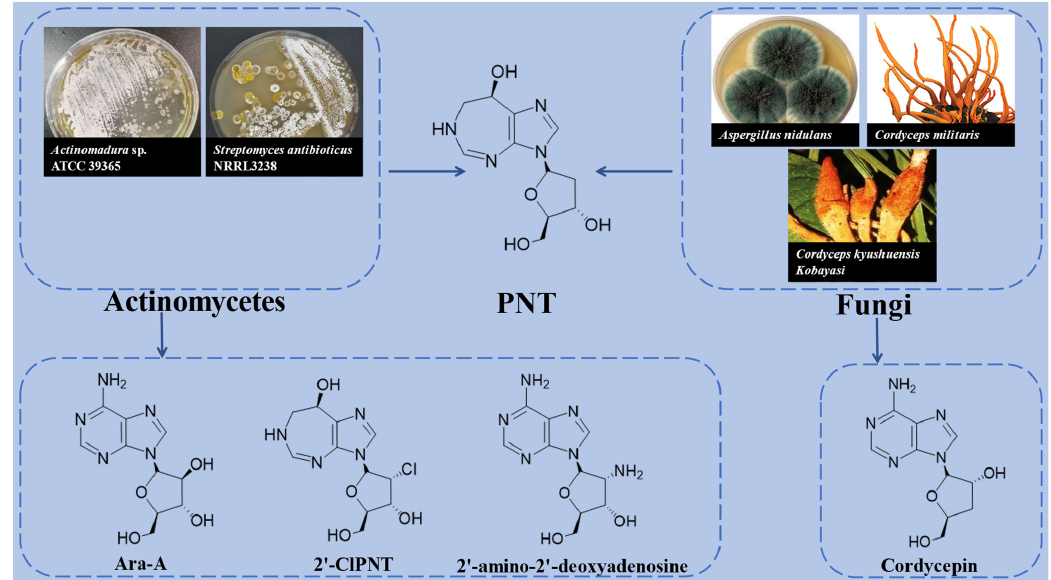
Figure 1. The structure and resource microorganisms of PNT and its associated products.